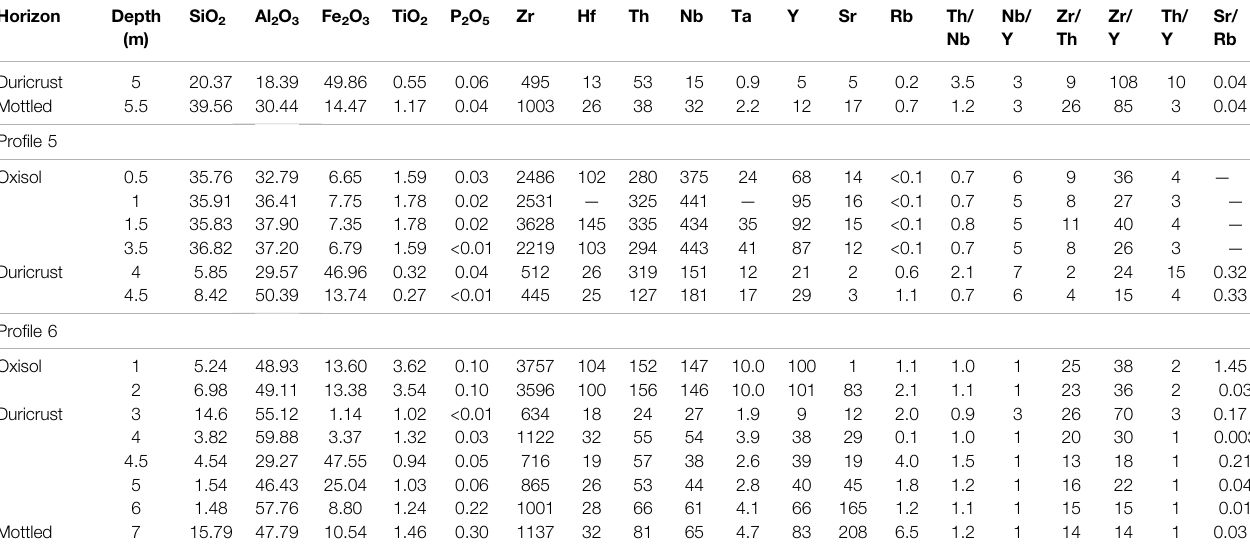
( Figure 2 ) are related to the coexistence of quartz, kaolinite, and gibbsite; the highest Al 2 O 3 content in pro fi le 6 is related to the predominance of kaolinite in the mottled horizon and of gibbsite in the Oxisol, and the highest SiO 2 content in pro fi les 3 and 4 is related to the predominance of quartz along the pro fi les. In all pro fi les, the Hf, Nb, Ta, Th, TiO 2 , Y, and Zr